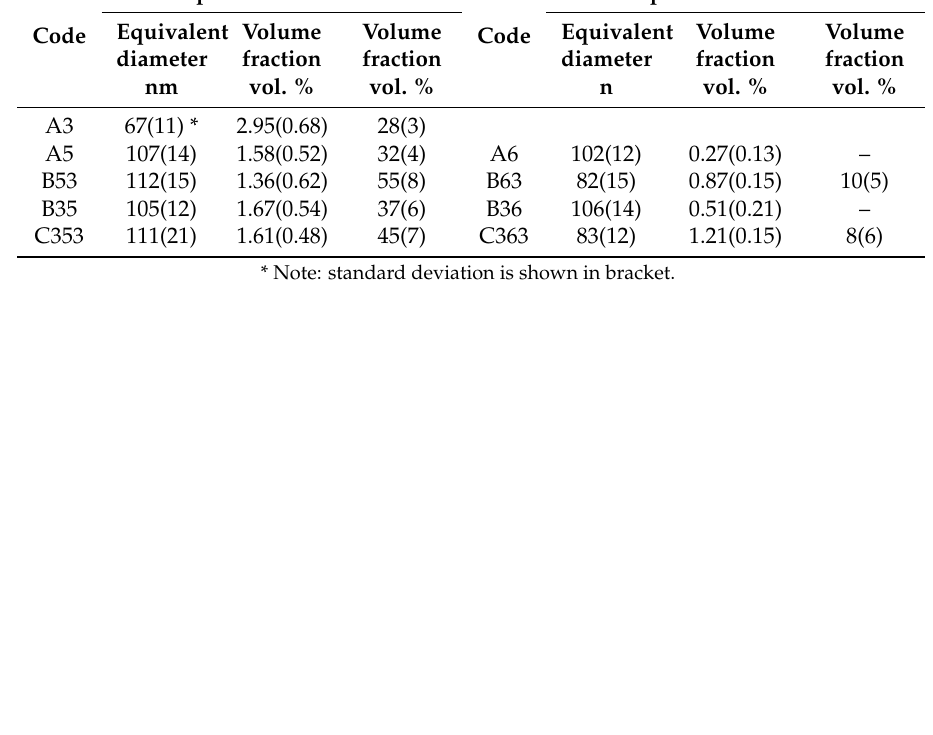
Figure 3e. It is observed that a low volume fraction of dispersoids still remains after B36 (Figure 3e) due to the incompletely dissolved dispersoids.